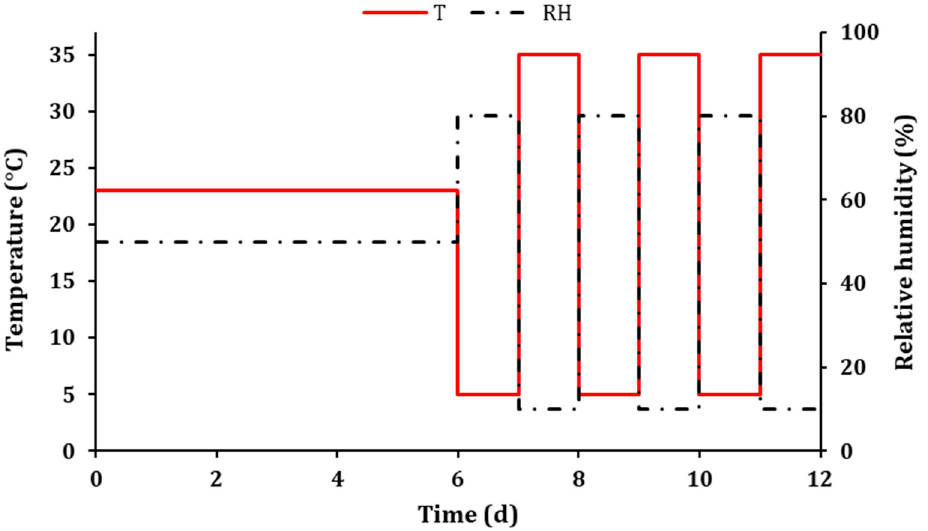
Figure 3. Temperature and relative humidity cycling applied to PLA and PF printed samples using an infill of 10% in the climatic chamber.